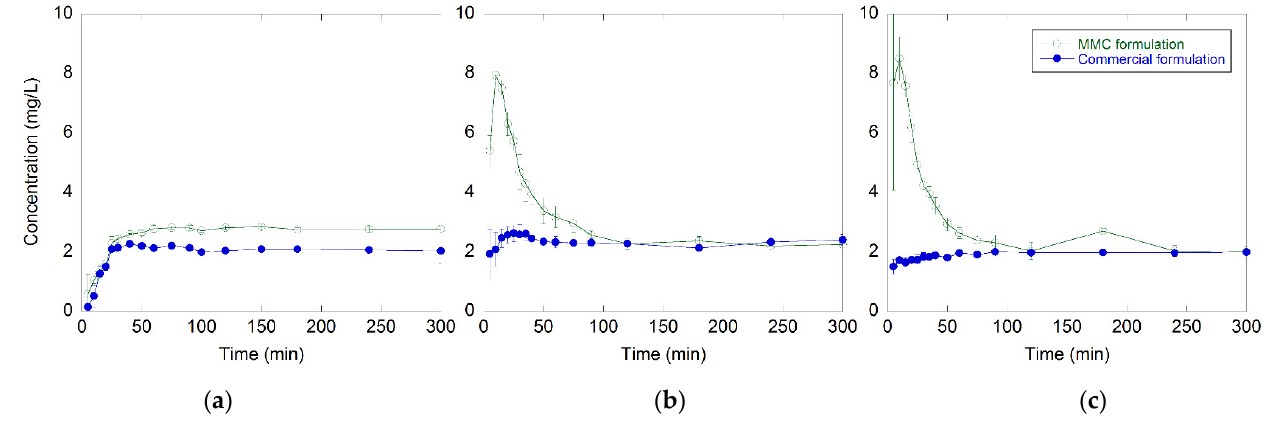
Figure 3. ( a ) Celecoxib dissolution profiles for the MMC and the commercially available formulation at pH 1.2, ( b ) 4.5, and ( c ) pH 6.8. All measurements were made in triplicates, and data are displayed as the mean values with corresponding standard deviations.